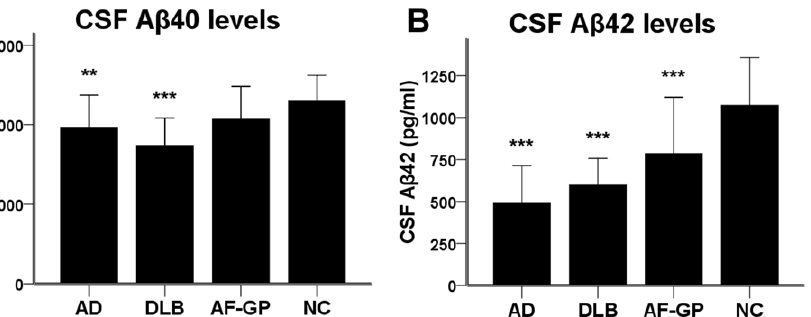
Figure 2. The CSF Ab 40 and Ab 42 levels in AD, DLB, AF-GP and normal control subjects. (A) The levels of CSF Ab 40 were significantly lower in patients with AD and DLB compared to normal controls. There was a trend towards decreased CSF Ab 40 levels in patients with AF-GP compared to normal controls (p=0.075). (B) The levels of CSF Ab 42 were significantly lower in patients with AD, DLB and AF-GP compared to normal controls. Statistically significant difference was calculated using one-way ANOVA, followed by Bonferroni’s post hoc test. Data are means 6 SD. Abbreviations: Ab , amyloid- b protein; AD, Alzheimer’s disease; DLB, dementia with Lewy body; AF-GP, the atrophic form of general paresis; NC, normal control. (**p , 0.01, ***p ,